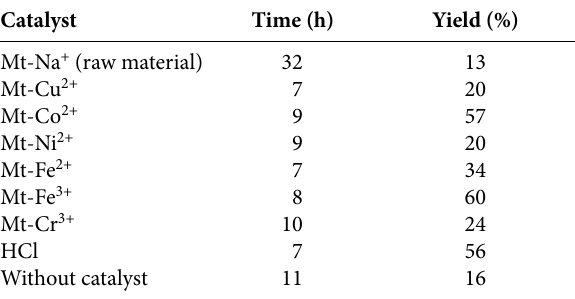
Table 3. Effect of the exchanged cation on Biginelli reaction.